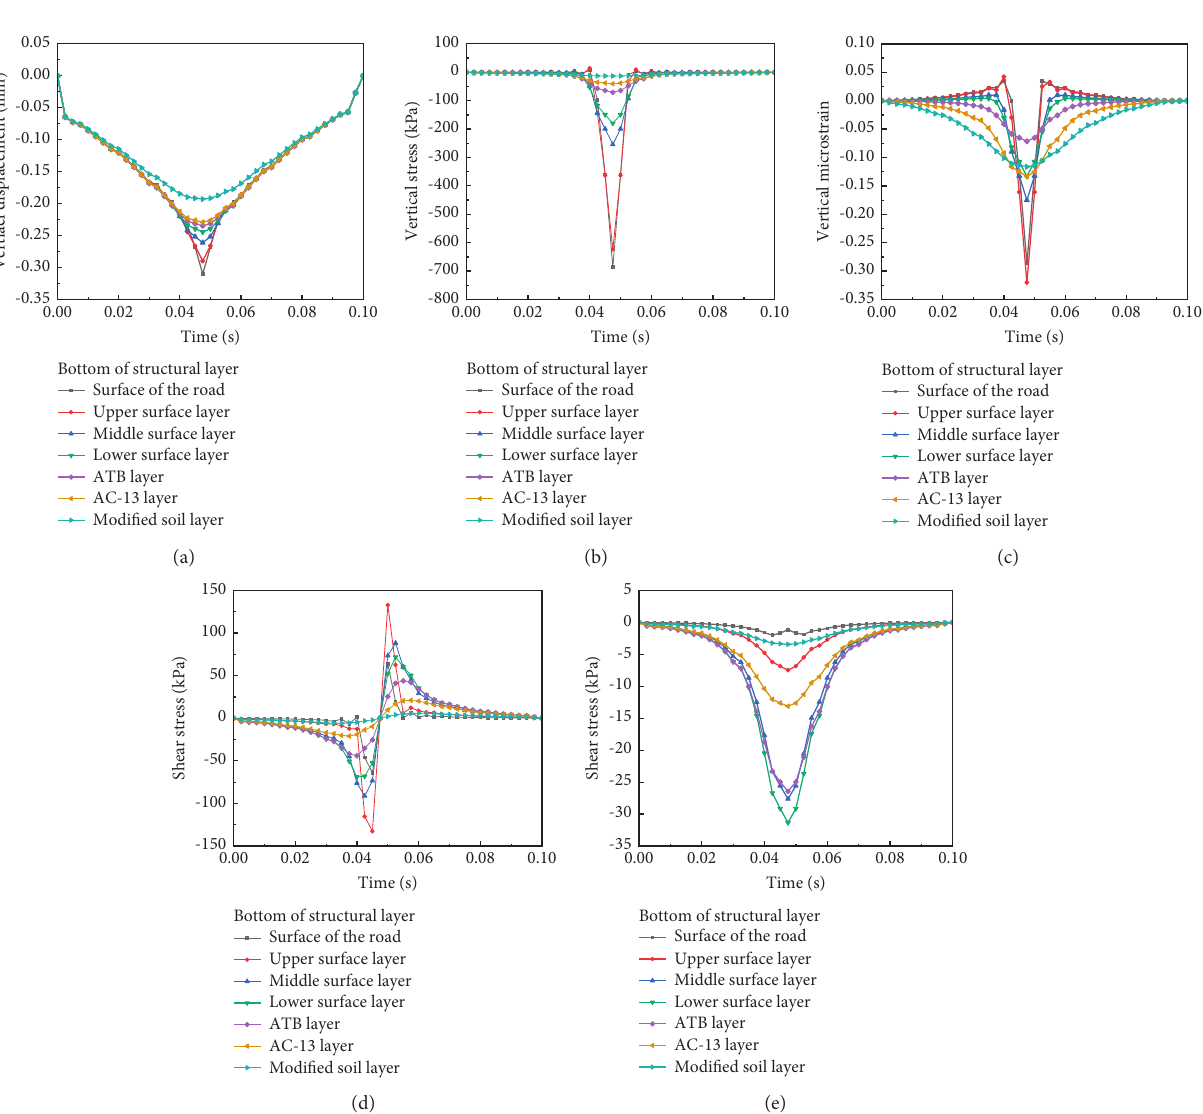
Figure 6: Time history curve of (a) vertical displacement, (b) vertical stress, (c) vertical micro strain, (d) longitudinal shear stress, and (e) transverse shear stress at each layer of structure